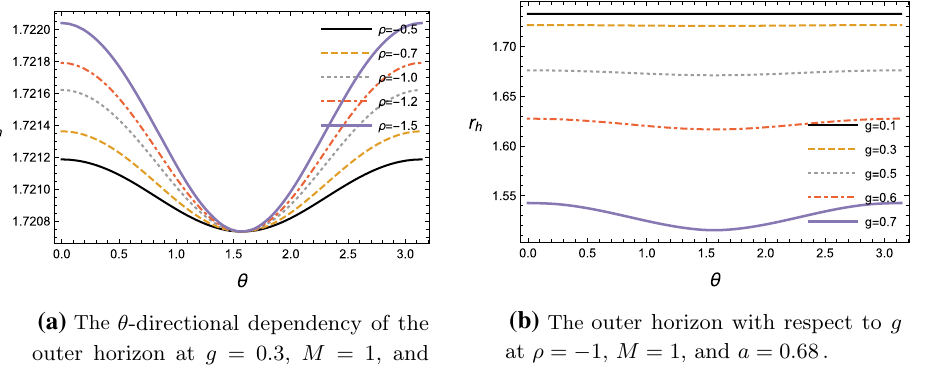
outer horizon with respect to g at ρ = − 1, M = 1, and a = 0 . 68.